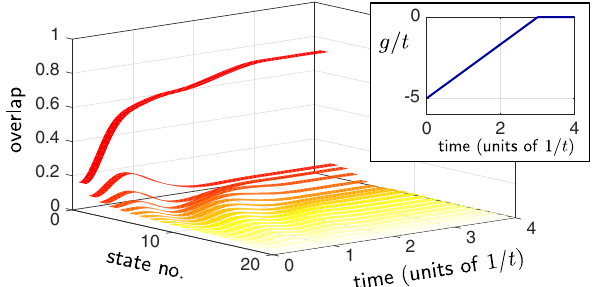
/ t ¼ 0.2 in the strong- z